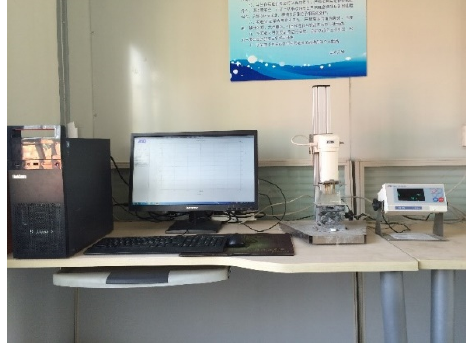
Figure 1. SV-100 vibrating type viscometer.